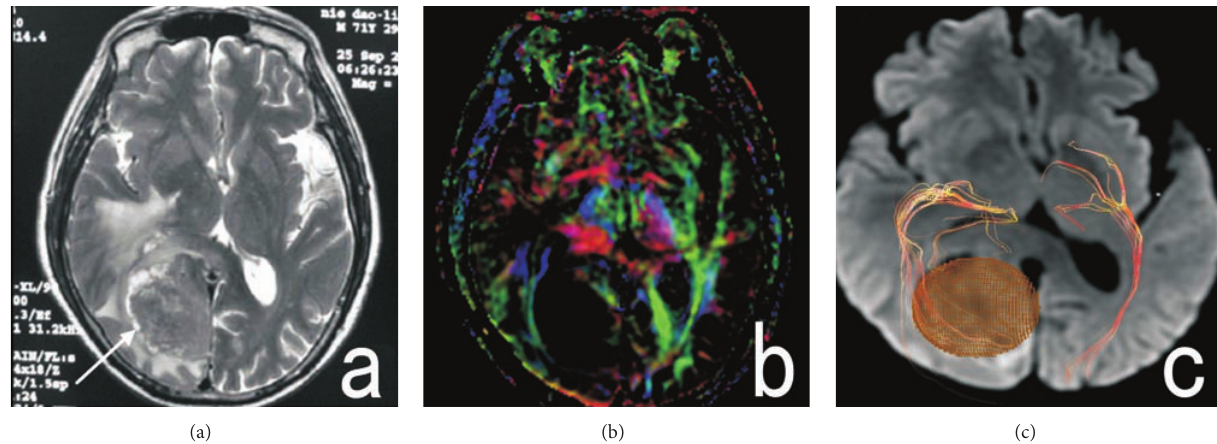
Figure 4: The T 2 WI image of right occipital lobe metastases in a 71-year-old man ((a), arrow). The FA value of right GCT decreases ((b), arrow). DTT map shows the right GCT fibers ((c), arrow) are disrupted by the metastasis (brown